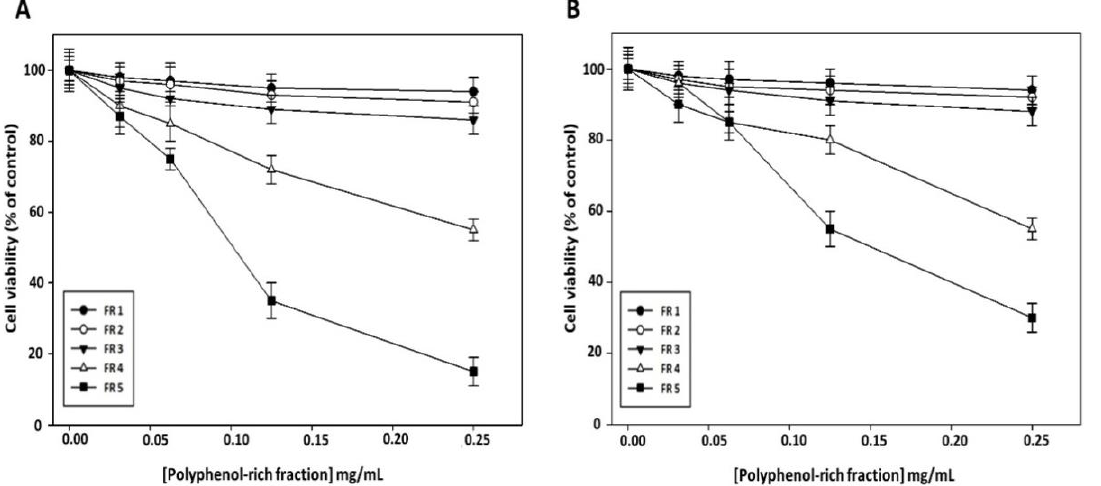
Figure 4. Effect of polyphenol-rich fractions on HNSCC cell viability. Cal-33 ( A ) and JHU-SCC-011 ( B ) cells were treated for 72 h with increasing amounts of polyphenol-rich fractions (from 0.03 mg/mL to 0.25 mg/mL) and then cell viability was assessed by MTT assay. Results are presented as a percentage of the control cells. Error bars depict the standard deviation ± SD of quadruplicated measurements and are representative of three separate experiments.